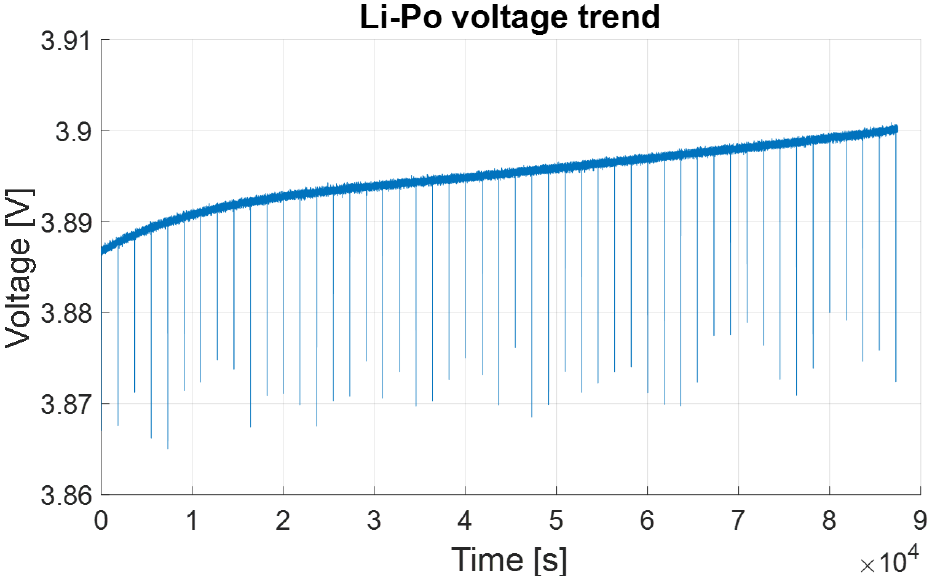
Figure 11. Li-Po voltage trend with radio transmissions every 30 min, MPPT set to 80% and ∆ T = 8 °C.